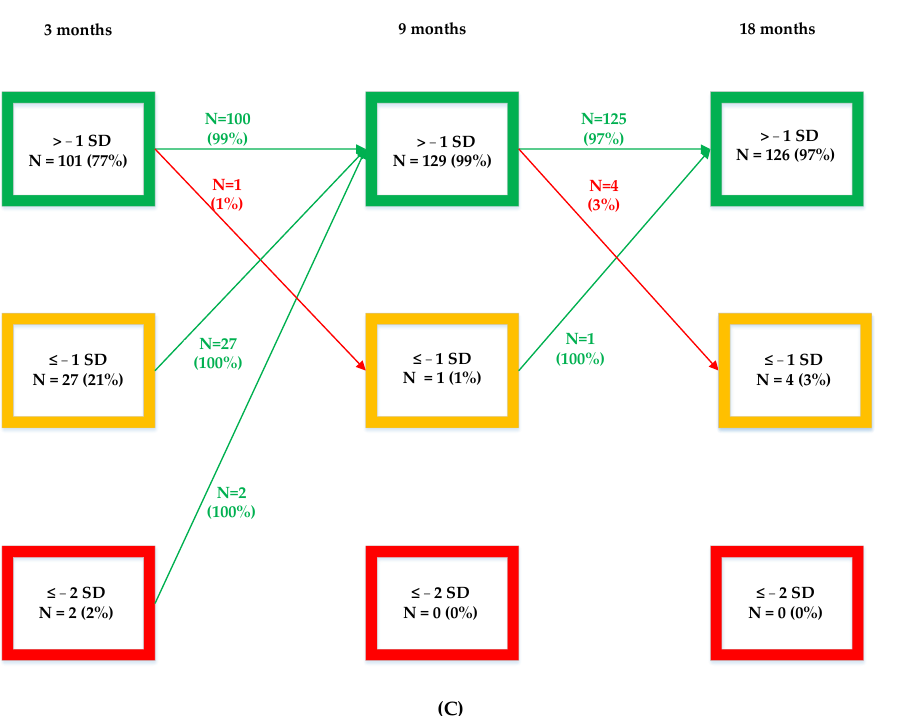
Figure 3. ( A – C ). Bayley-III development trajectories of total motor development, gross motor, and fine motor development at 3, 9, and 18 months. * Both total motor scores that fall within the classification “superior” (120–129 ) “high average” (110–119) or “average” (90–109) are displayed within the group “average”. ** Total motor scores between 80 and 89 are shown in the “below average” group. *** Both scores that fall within the classification “borderline” (70–79) and “extremely low” are displayed within the “delayed” group. Bayley-III = Bayley Scales of Infant and Toddler Development, Third Edition.